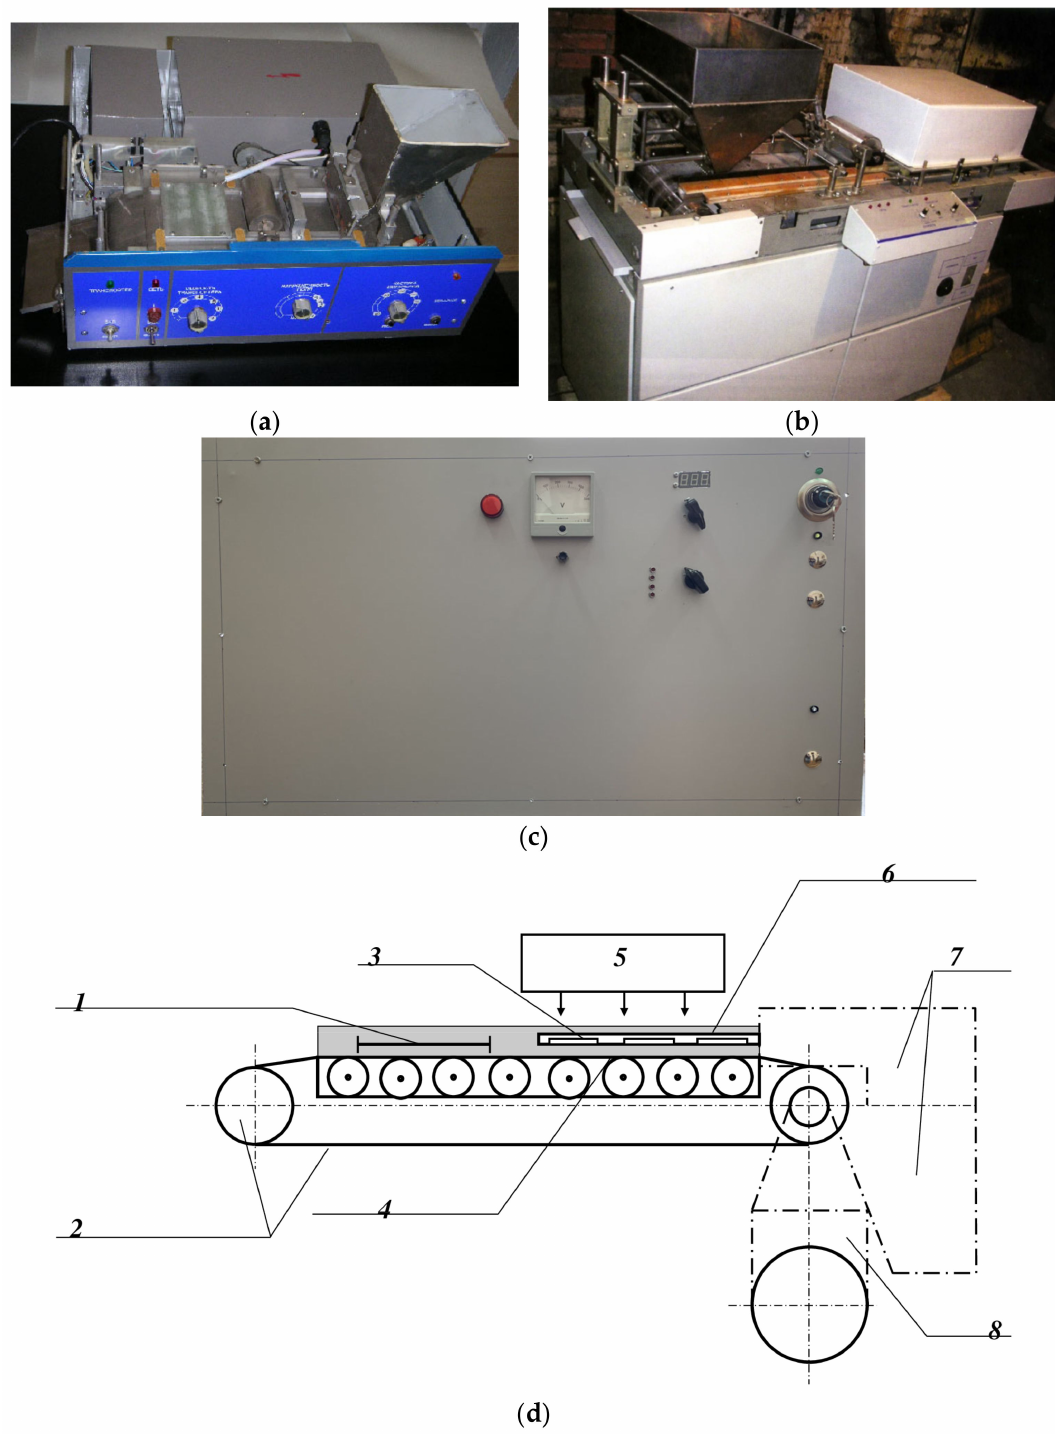
Figure 4. Modular installations for the treatment of mineral products by high-power nanosecond electromagnetic pulses with a capacity of ( a ) 20 kg/h, ( b ) 100–120 kg/h; ( c ) generator of